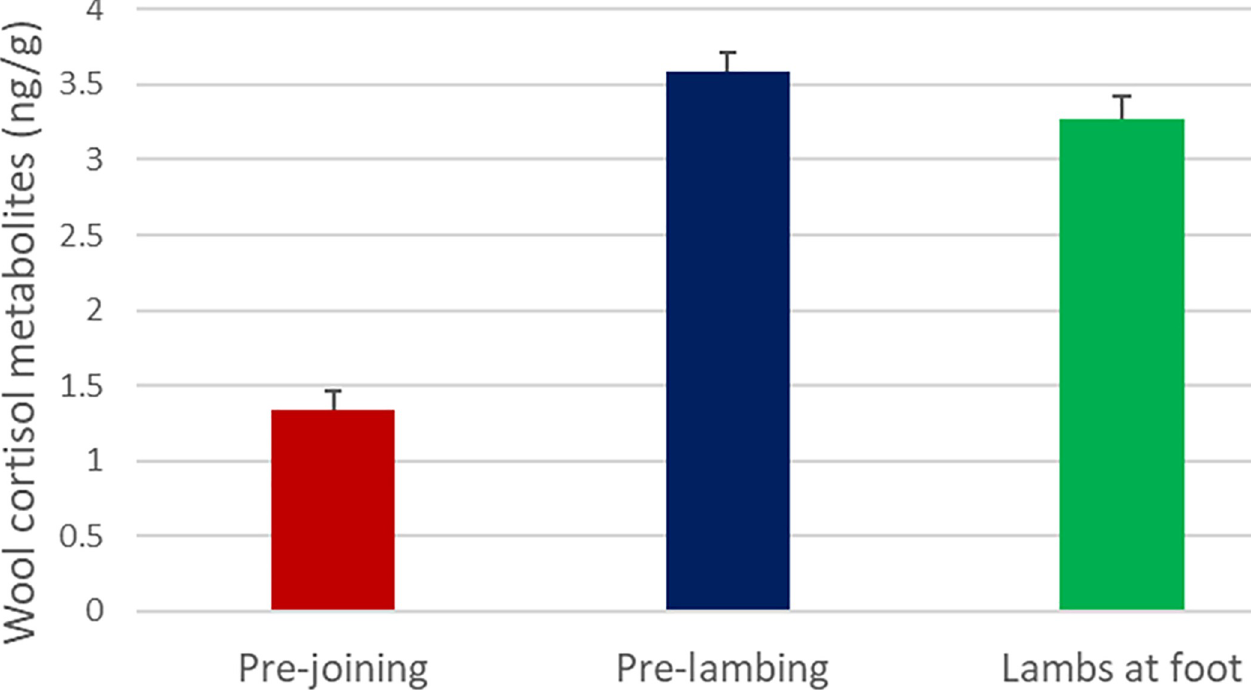
Fig 1. Merino ewe (n = 46) wool cortisol levels before, during and after pregnancy. Wool cortisol levels pre-joining showed significantly lower than levels for pre-lambing and lambs at foot. No significant difference in levels was shown between pre-lambing and lambs at foot.